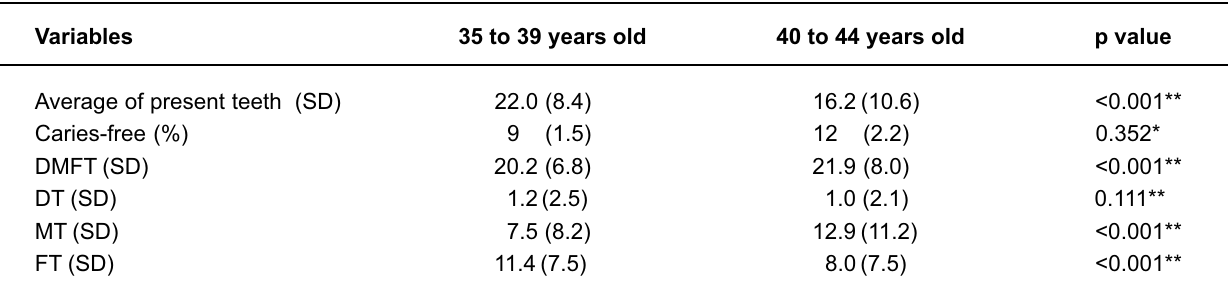
TABLE 3- Mean number of present teeth and caries experience according to age groups. Southeastern state of São Paulo, Brazil